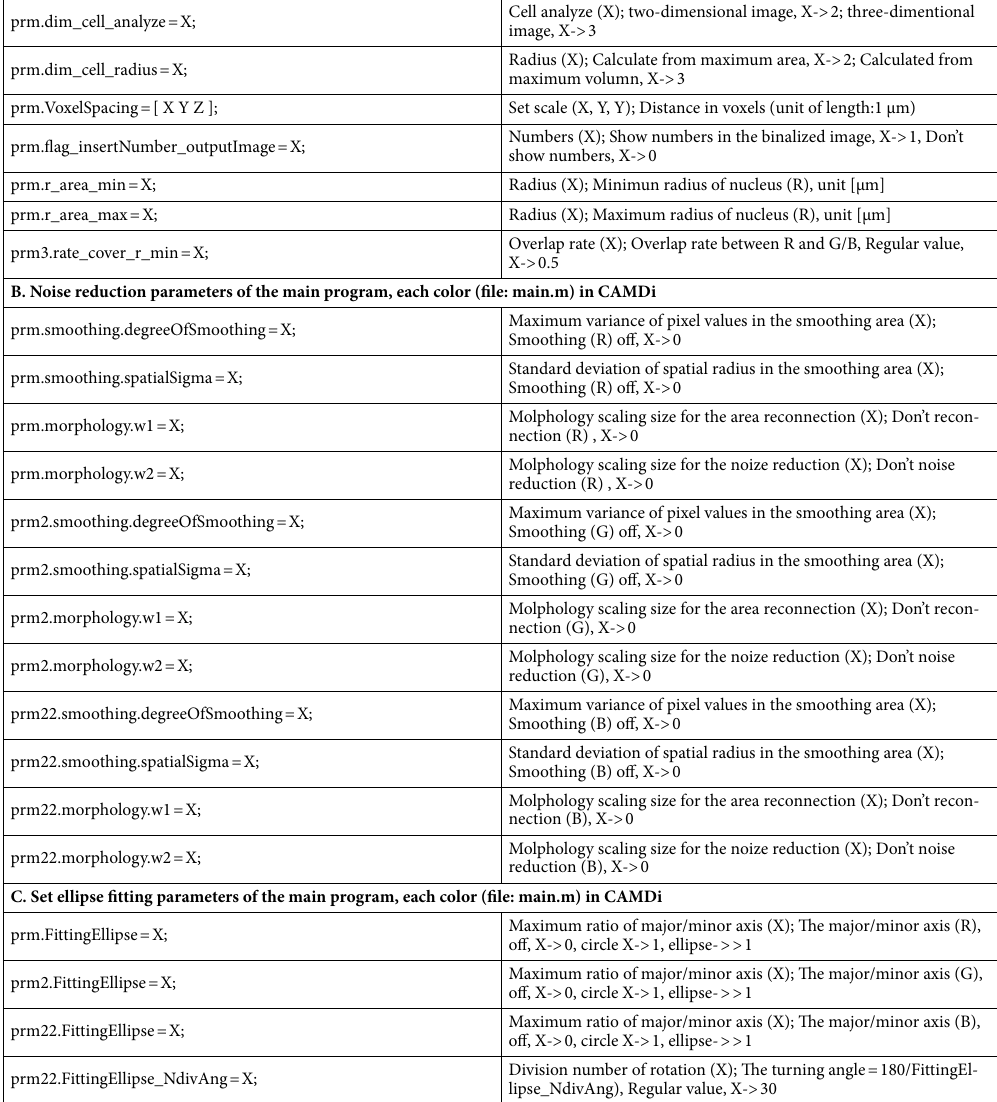
Table 1. Setting initial parameters of MATLAB